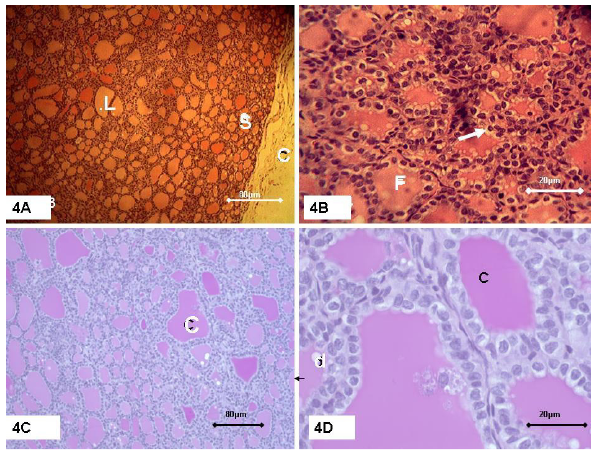
Fig. 3A. Photomicrograph of thyroid section of foetal WADG (95-125 days), showing thyroid gland with well-developed thyroid parenchyma containing several large follicles with colloid droplets (vacuoles) concentrated close to the centre of the gland; the capsule of the gland (C) well developed with some adipose tissue. H – E (bar scale 80 μm); Fig. 3B. Sections of 95-125 days thyroid taken close to the centre of the gland with follicles containing numerous colloid droplets (arrow) and completely filled with colloid, follicular cells invaginated into the lumen (L). Small follicles (S) also seen. H – E (scale bar 20 μm); Fig. 3C. Photomicrograph of section of 95-125 days thyroid with several elongated follicles that contained colloid (C). H – E (bar scale 80 μm); Fig. 3D. Sections of 95- 125 days thyroid with strongly stained PAS-positive colloid (C) with peripheral colloid droplets (d), Parafollicular cell (arrow) is apparent. PAS (bar scale 20 μm).